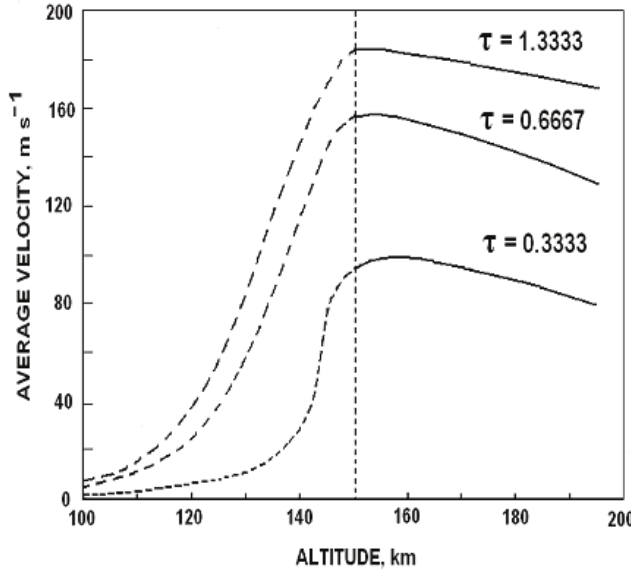
Figure 1. Variations in the average velocity of the thermospheric plasma with altitude at different characteristic times ( x ). The different curves show that the thermospheric plasma approaches greater velocities with increasing x , to reach a steady-state at different altitudes. The dashed lines are for functional completeness (these values are not physically